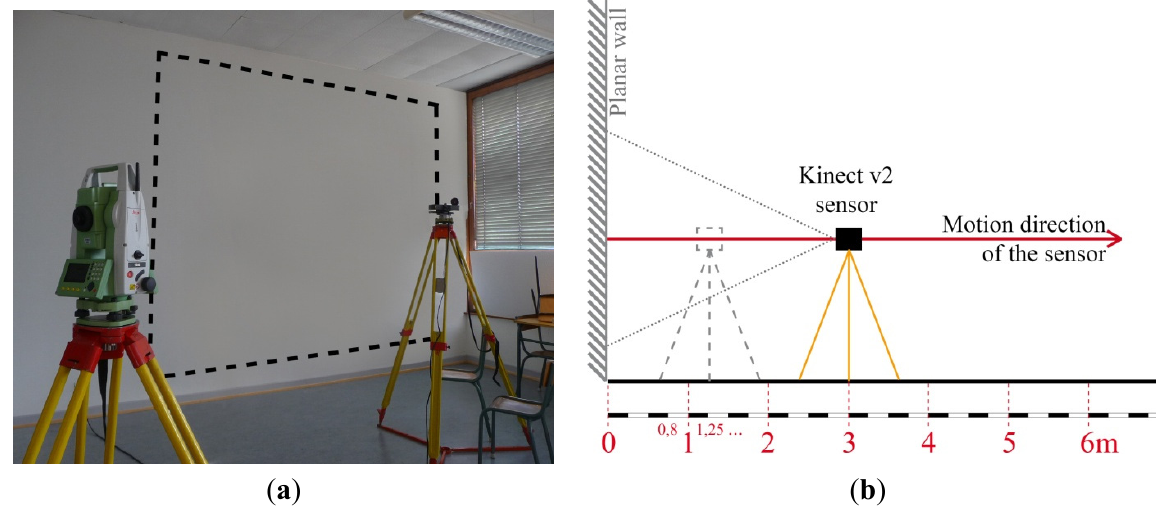
Figure 6. ( a ) Picture of the experimental setup with the observed area in dotted lines; ( b ) Global schema of the acquisition